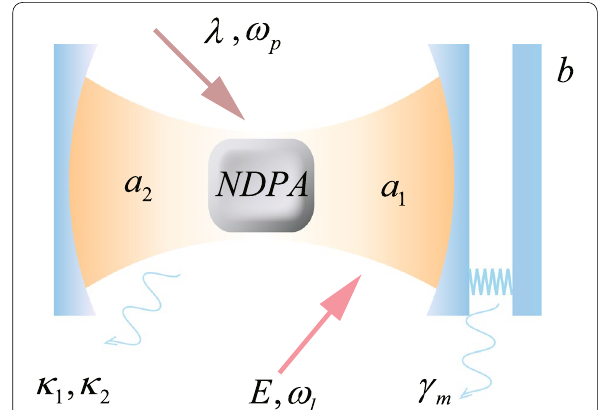
Fig. 1 Schematic illustration of the three‑mode optomechanical system with the nondegenerate parametric amplifier, which is composed of two optical modes and a mechanical oscillator. There are the beam‑splitter‑type interaction and the parametric‑down‑converted‑type interaction between two optical